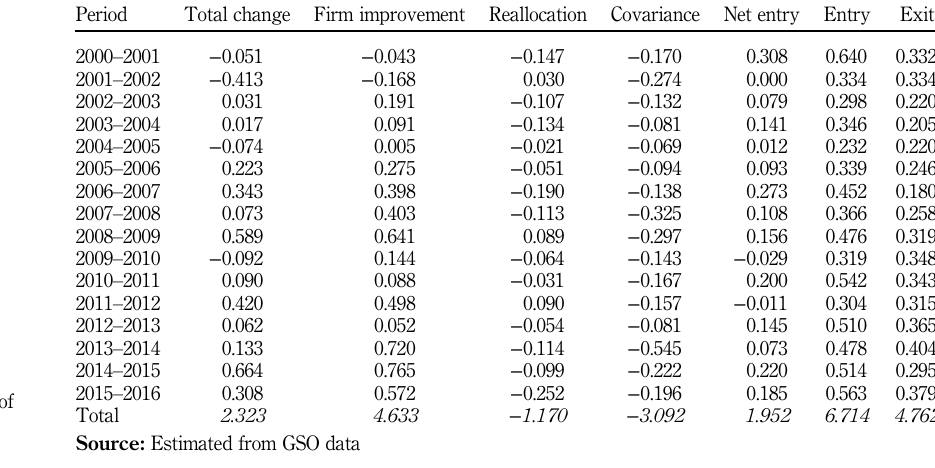
decomposition of productivity growth